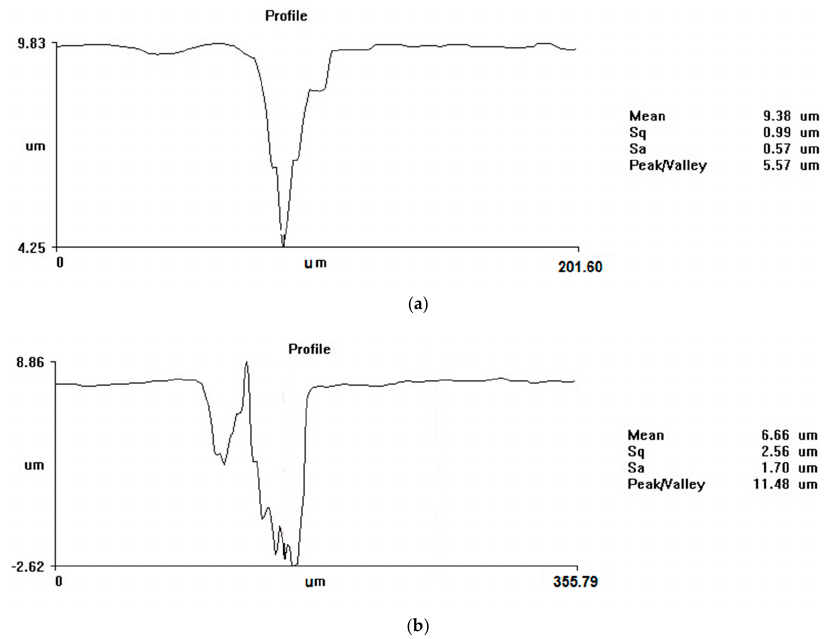
Table 1 . Characteristics of holes drilled in industrial steel with 500 pulses.